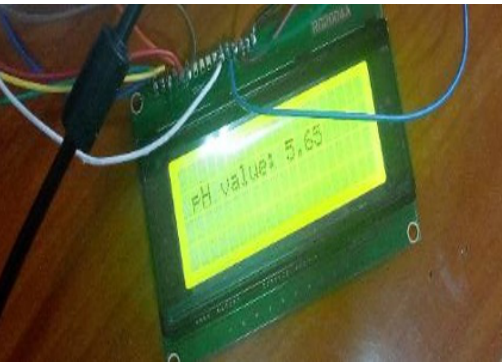
Fig. 11. Output in LCD